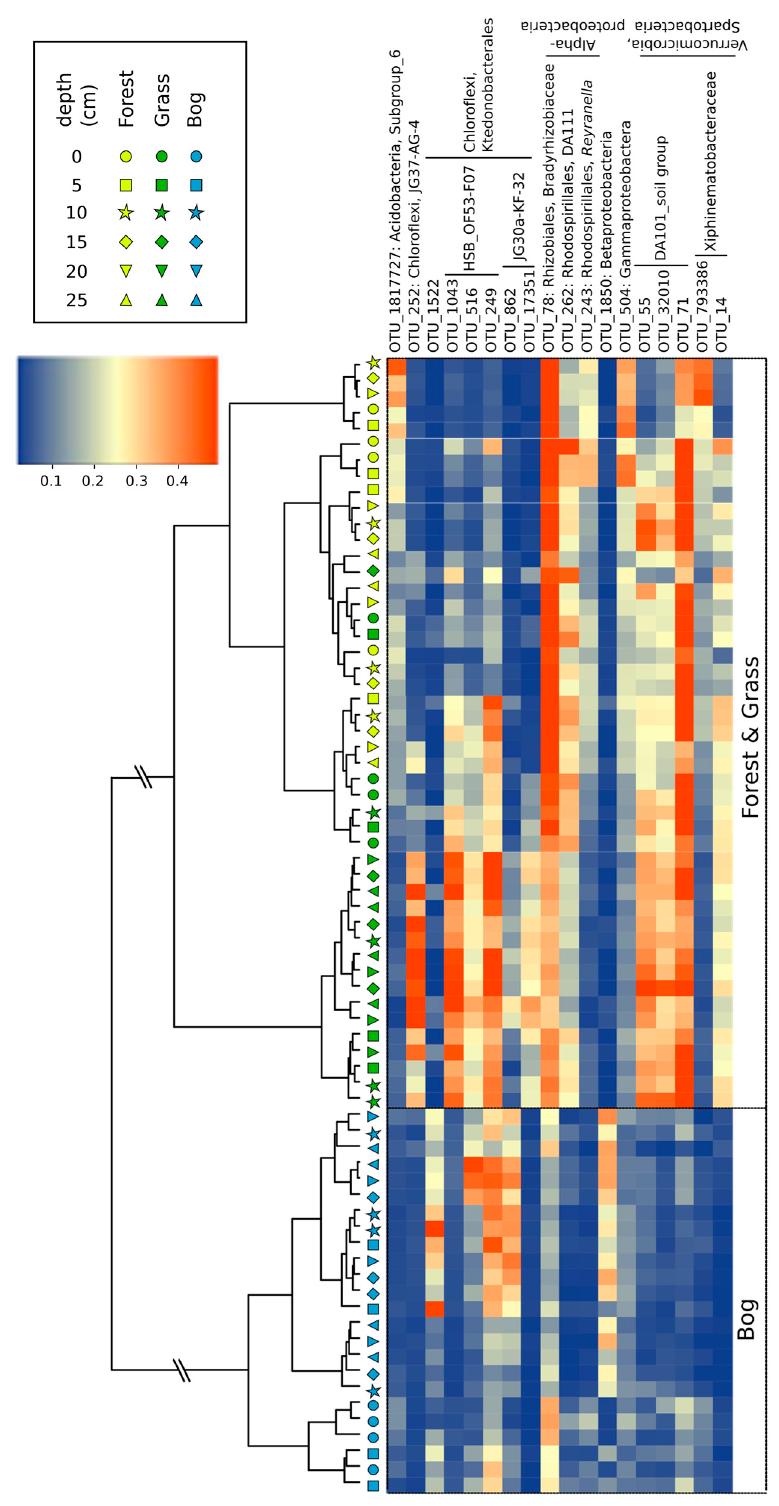
Figure 5. Heatmap of the OTUs derived from bacterial 16S rRNA genes. The OTUs with the highest loadings in a PCA analysis were selected. The samples and OTUs were clustered according to Euclidean distances between all Hellinger-transformed data. The taxonomy of OTUs was determined using the Silva classifier. The colored scale gives the percentage abundance of OTUs.